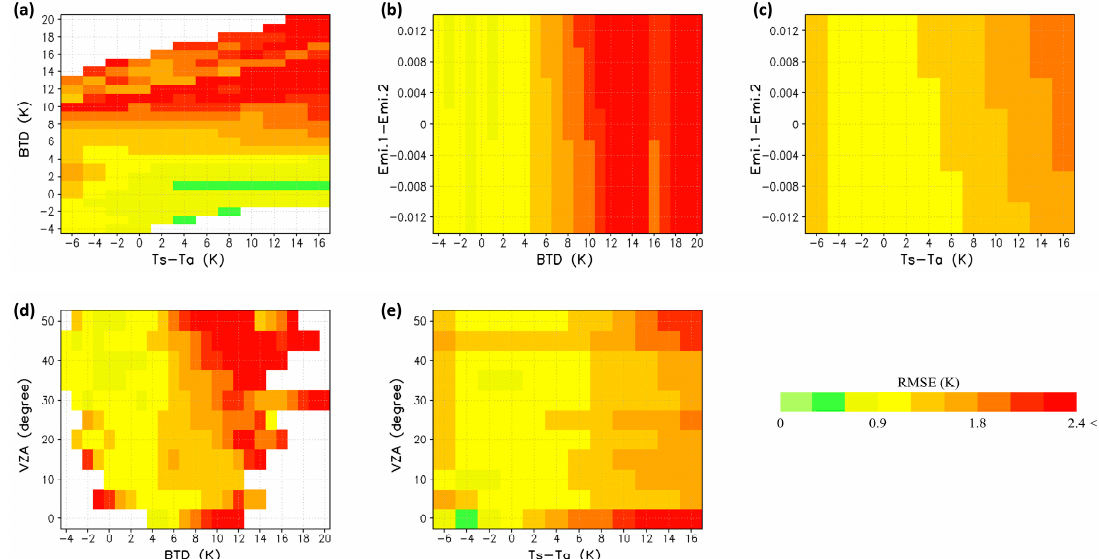
Figure 6. Distribution of RMSEs for the Himawari-8 LST retrieval algorithms based on various impacting factors: ( a ) brightness temperature differences (BTD) and surface lapse rate, ( b ) emissivity difference and BTD, ( c ) emissivity difference and surface lapse rate, ( d ) satellite viewing zenith angle (VZA) and BTD, and ( e ) VZA and surface lapse rate.